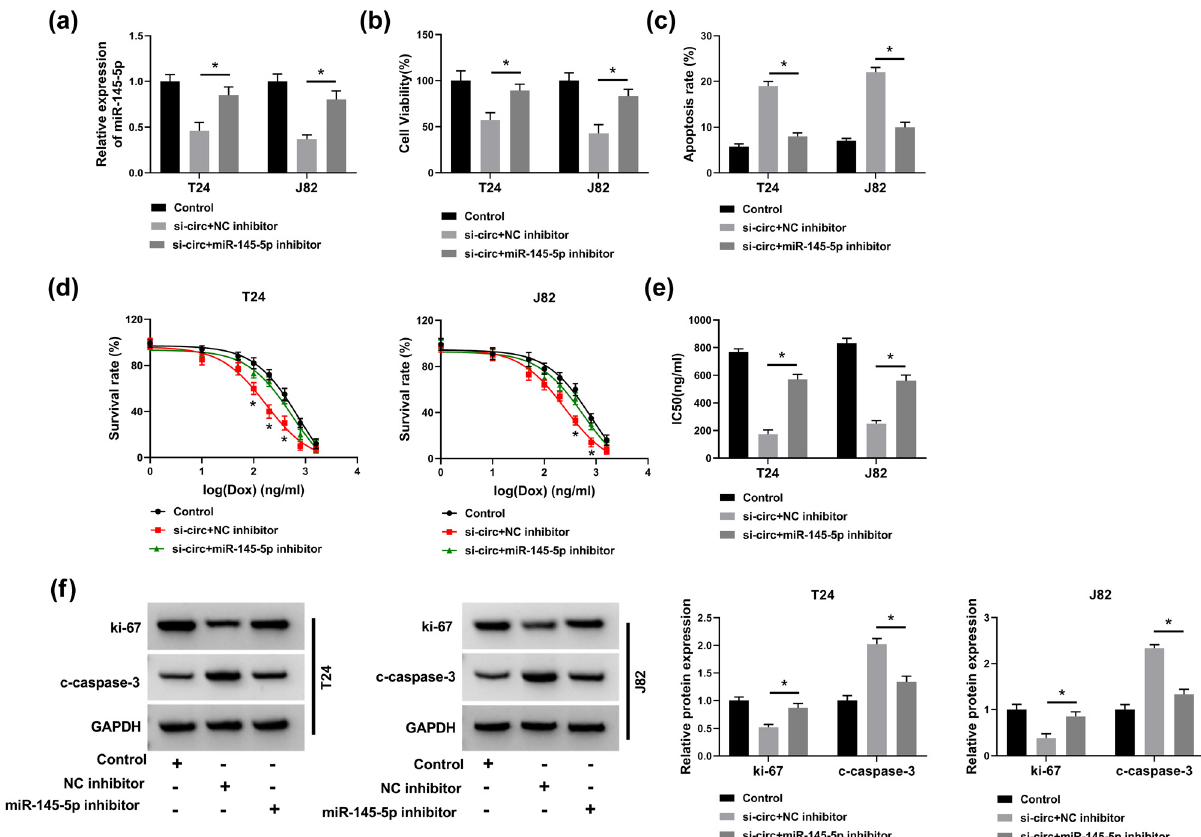
Figure 4: circ_VANGL1 targeted miR - 145 - 5p to elevate cell viability, repress cell apoptosis, and reduce doxorubicin sensitivity in bladder cancer cells. ( a – f ) T24 and J82 cells were transfected with si - circ + NC inhibitor or si - circ + miR - 145 - 5p inhibitor, respectively. ( a ) The level of miR - 145 - 5p was determined by RT - qPCR. ( b ) CCK8 assay was performed to detect cell viability. ( c ) Cell apoptosis rate was detected by fl ow cytometry analysis. ( d ) T24 and J82 cells treated with di ff erent concentrations of doxorubicin, and cell survival rate was determined by fl ow cytometry analysis. ( e ) The IC 50 values for the growth of the transfected T24 and J82 cells treated with doxorubicin. ( f ) Western blot was used to detect the protein levels of c - caspase - 3 and ki - 67. * P <